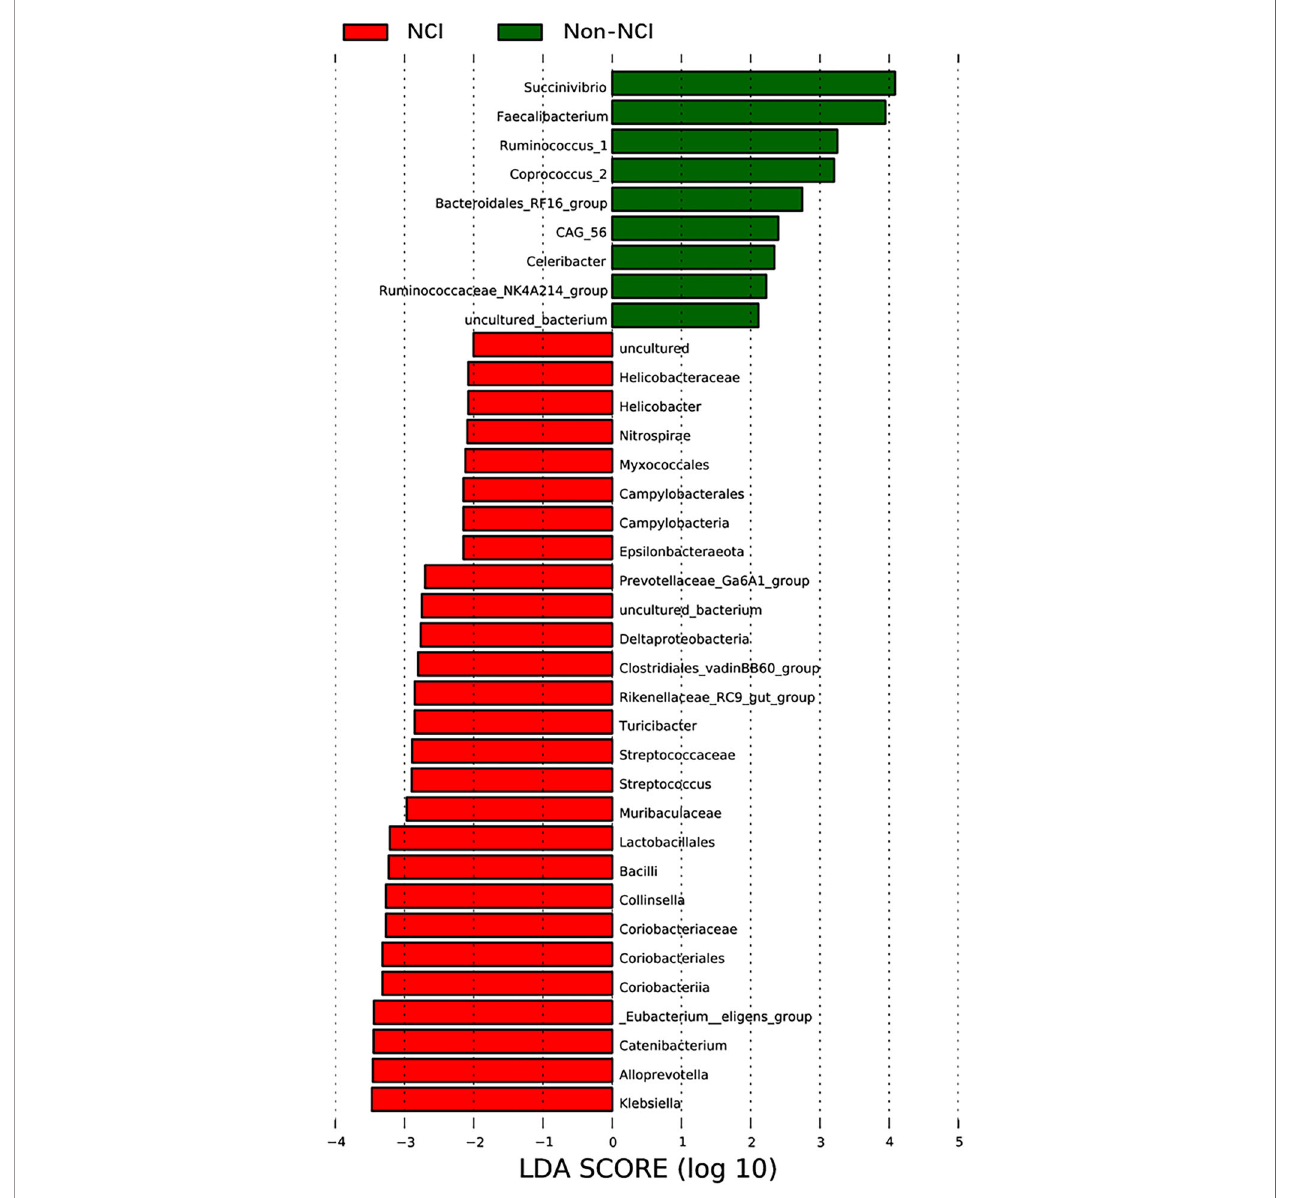
FIGURE 3 | LEfSe was used to identify the most differentially abundant taxa of bacterial communities between the NCI and non-NCI groups, with LDA score >2 (b, d). NCI group, HIV-infected persons with neurocognitive impairment; non-NCI, HIV-infected persons without neurocognitive impairment; LEfSe, linear discriminant analysis effect size; LDA, linear discriminant